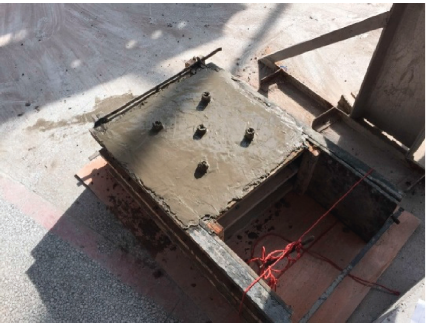
Figure 1: The mold used in the experiments. Table 1: Mixing proportions used to prepare the different concrete